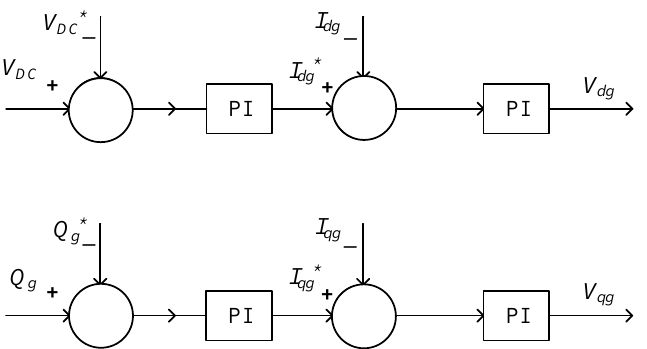
Figure 3. GSC control loops: DC bus voltage ( top loop), and grid-side reactive power ( bottom loop). Reference values labeled with *.